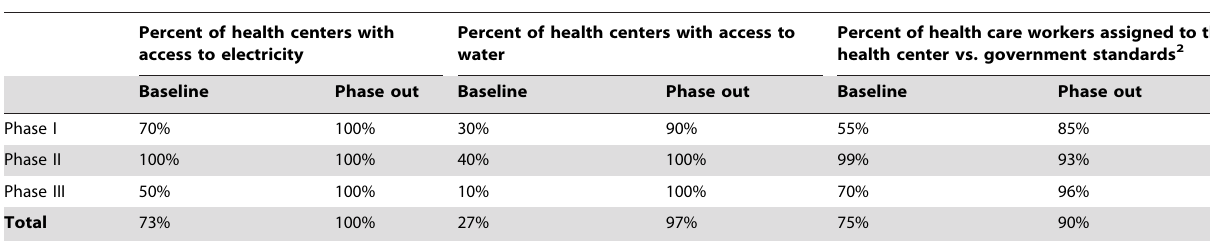
Table 1. Resources in the 30 EMRI 1 health centers during the 18-month intervention period.